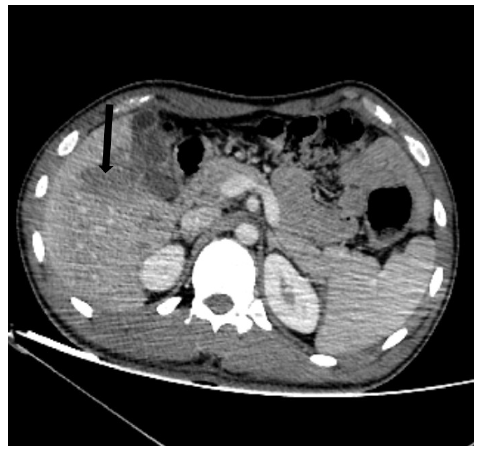
Figure 2. A 48-year-old male patient with road traffic accident. CECT abdomen venous phase image showing a laceration > 3cm in segment 5 of liver (black arrow) s/o grade III hepatic injury.